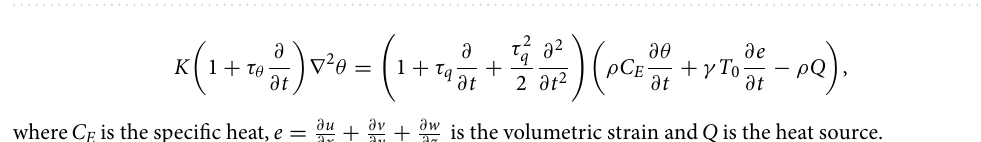
Figure 1. schematic diagram of the